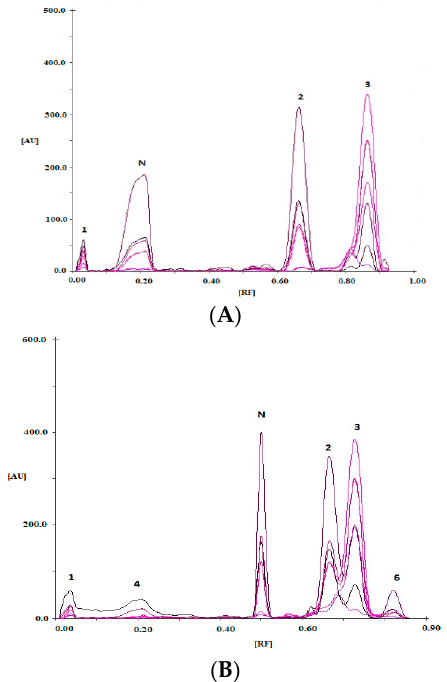
Figure 6. Densitogram of naproxen (N) in water at pH ≈ 2.60 (III), which was irradiated (254 nm) for 10 h and analyzed using: ( A ) TOL-ACE-CHL; 2:5:12, v/v/v; and ( B ) AcOH-Hex-ACE, 0.10:10:10 v/v/v as mobile phases, where: 1, 2, 3, 4, 6—degradation products of naproxen; and 2 was identified as naproxen ethyl ester.